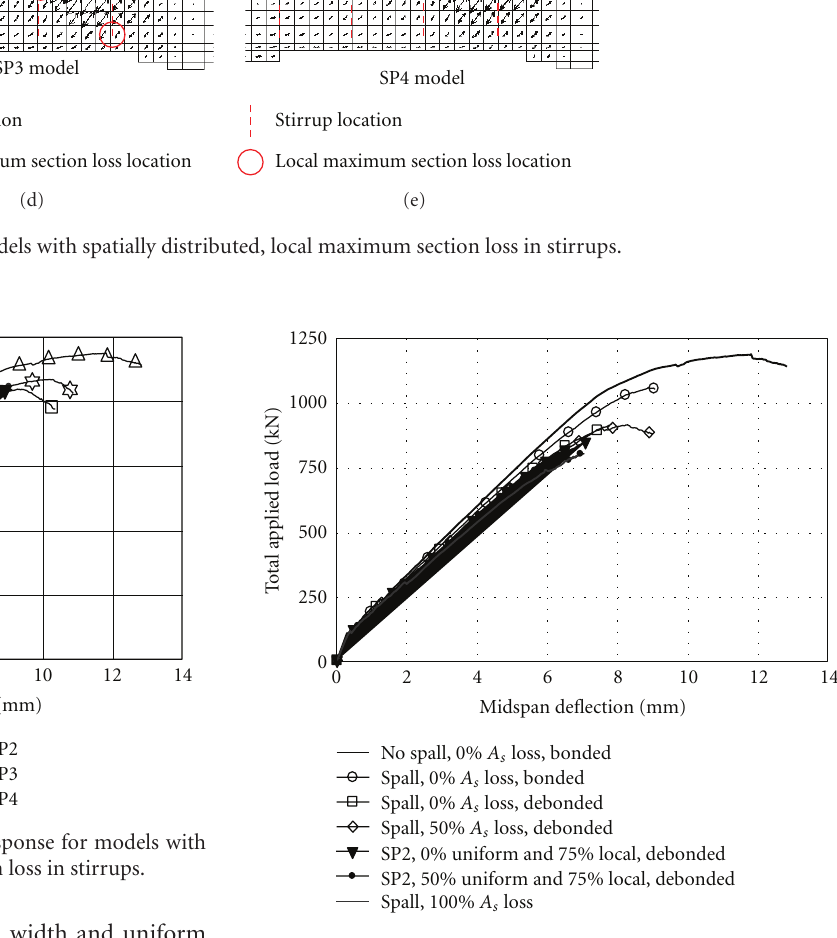
Figure 14: FE predicted load-deflection response for models with fully debonded concrete-rebar